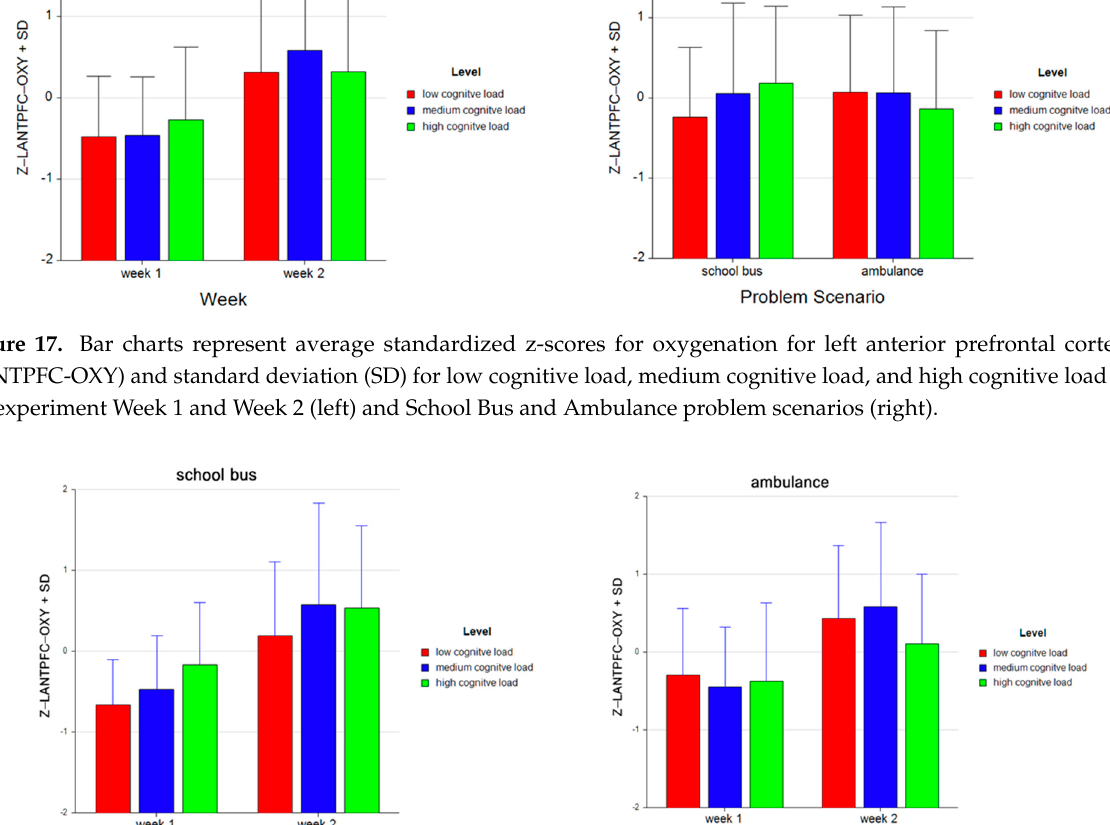
Figure 19. Line plots represent interaction effects of Level and Week (left) and Level and Problem (right) on average stand- ardized z scores for oxygenation for right anterior prefrontal cortex (Z-RANTPFC-OXY) with the error bars representing the standard error of the mean statistic. Differences in average oxygenation for Z-RANTPFC are represented across low, medium, and high cognitive load tasks for Week 1 and Week 2 and for School Bus and Ambulance problem scenarios. Tukey HSD post hoc tests revealed that, for Week 1, average oxygenation for the RANTPFC region increased as the difficulty level of the tasks increased for Week 1 (M = − 0.468, SD =0.697 for low, M = − 0.493, SD = 0.660 for medium, M = − 0.281, SD = 0.857 for high level tasks). For Week 2, average oxygenation was higher for medium level tasks (M = 0.587, SD = 1.161), followed by low (M = 0.333, SD = 0.922) and high (M = 0.322, SD = 1.016) level tasks. Overall, there was an increase in average oxygenation from Week 1 (M = − 0.414, SD = 0.745) to Week 2 (M = 0.414, SD = 1.049). For the School Bus problem, it was found that average oxygenation for the RANTPFC region increased as the difficulty level increased (M = − 0.214, SD = 0.857 for low, M = 0.046, SD = 1.112 for medium, M = 0.169, SD = 0.995 for high level tasks). For the Ambulance problem, it was found that the average oxygenation level was highest for low level tasks (M = 0.079, SD = 0.941), followed by medium (M = 0.048, SD = 1.099) and high level tasks (M = − 0.127, SD = 0.958) (see Figure 20). Similarly, an increasing pattern is observed from Week 1 to Week 2 within each level